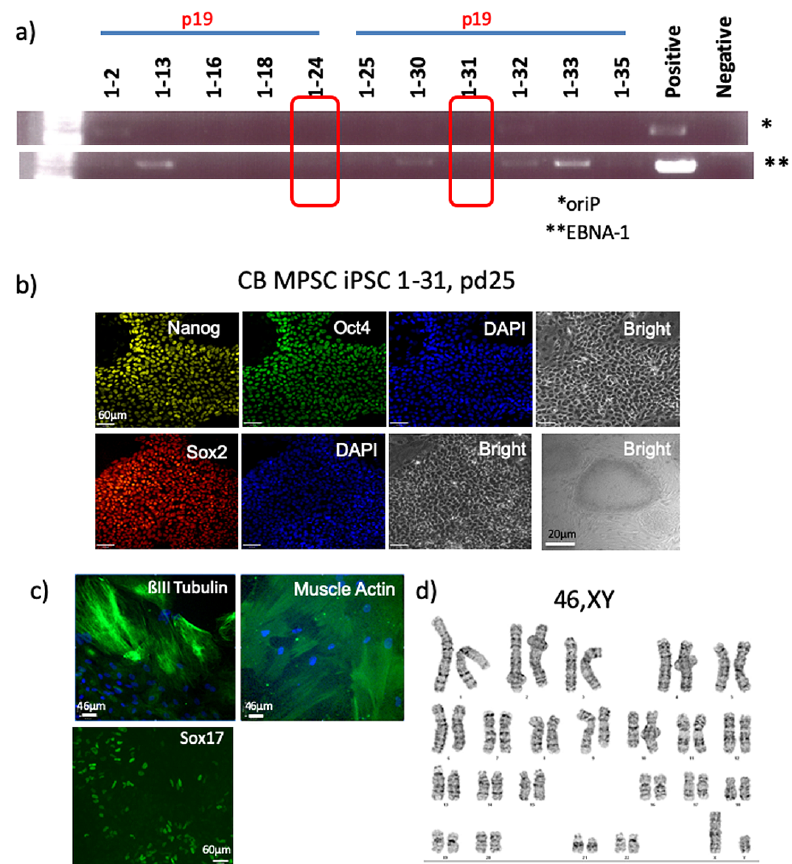
Figure 6. Umbilical Cord Blood Reprogramming. ( a ) PCR demonstrating the loss of episome vectors from reprogrammed umbilical cord blood (UCB) cells. The episome vector is not present in UCB-iPSC lines 24 and 31. ( b ) Episome-free UCB-iPSC are positive for the pluripotency markers Oct4, Sox2 and Nanog. Scale bar = 60 µ m for all ICC panels and scale bar = 20 µ m for the phase contrast panel. ( c ) UCB-iPSC were successfully differentiated into ectoderm (ßIII-Tubulin), mesoderm (SMA) and endoderm (Sox17). Scale bar = 46µm for all panels. ( d ) A normal diploid male karyotype is observed.